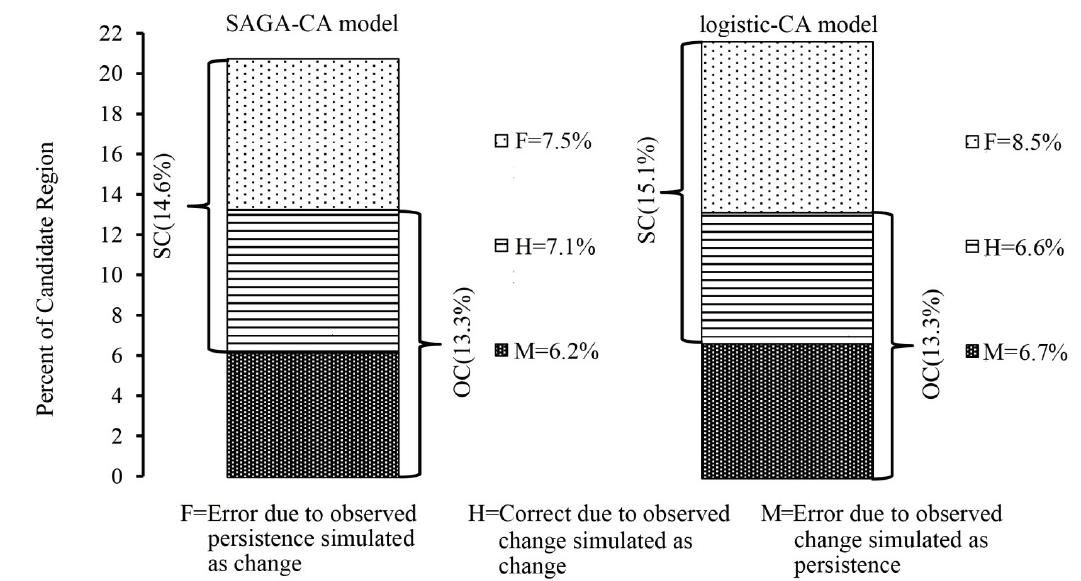
Figure 8. Misses, hits and false alarms in the non-urban area of 1991, where SC denotes simulated change and OC denotes observed change from 1991 to 2001.